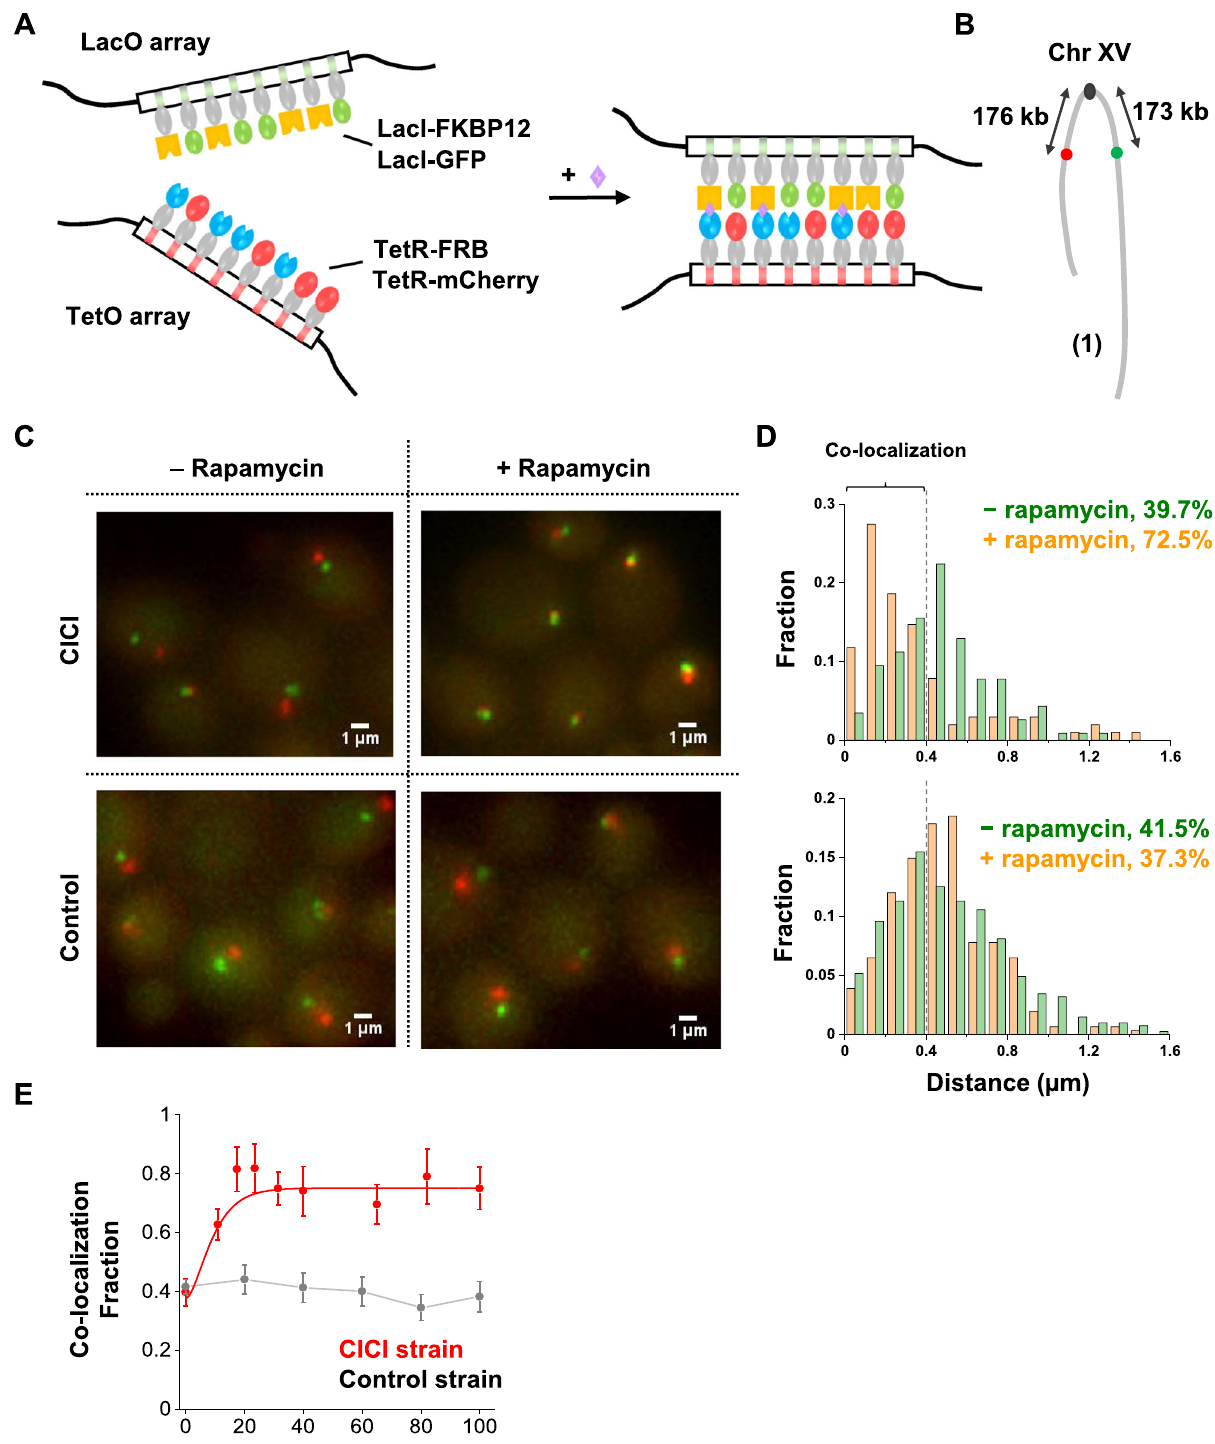
contact frequency, we derived the initial mean distance between dots, initial co-localization probability, CICI ef fi ciency (net co- localization gains at steady state), and t 1/2 of CICI formation for each loci pair using the data in Fig. 2C (Methods), and